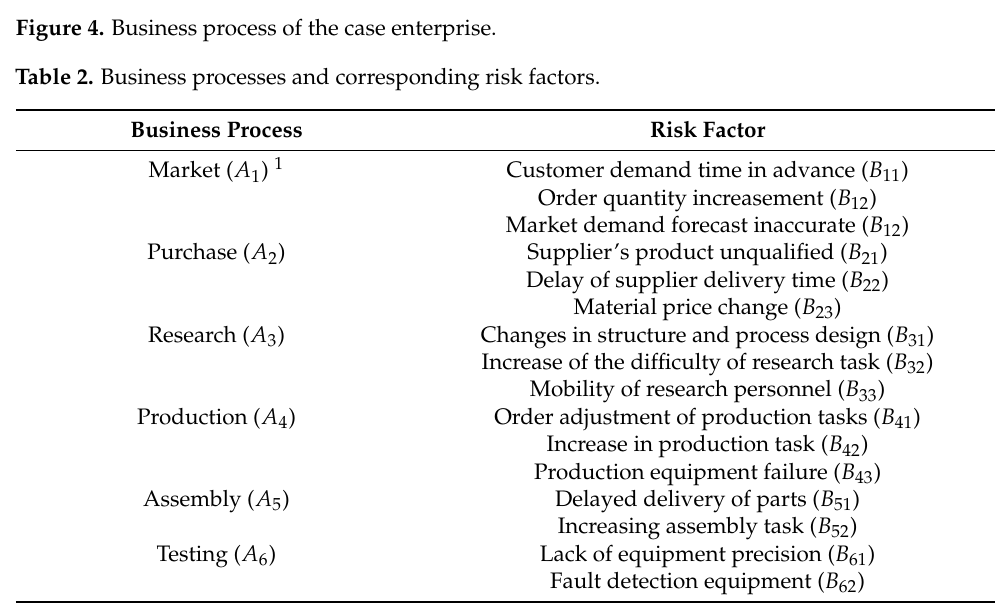
Table 5. CPT(b). Risk Factor